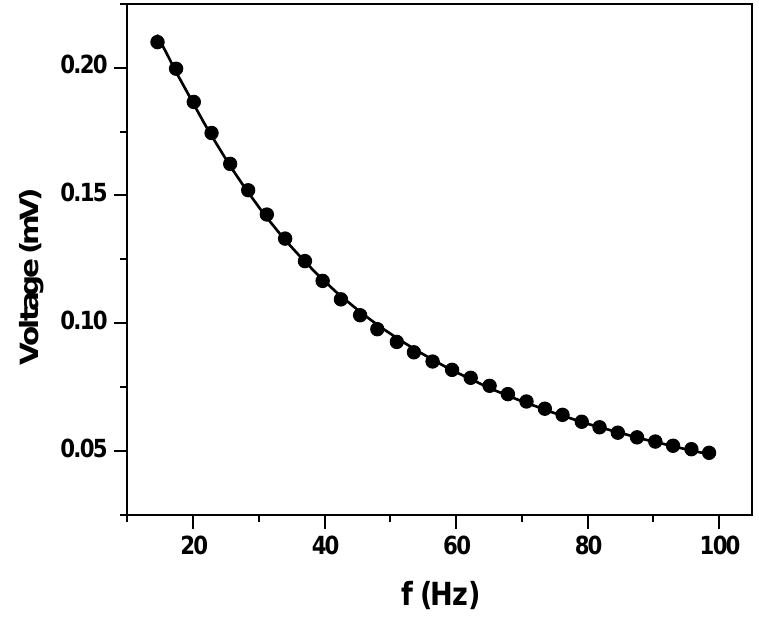
Figure 2. LDR voltage in function of the frequency of light pulses. The continuous line is the result of